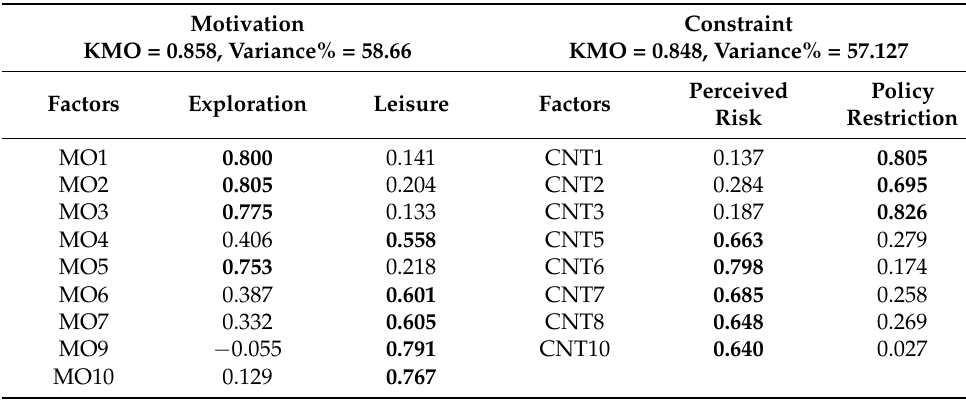
Table 3. The results of exploratory factor analysis (EFA). Motivation KMO = 0.858, Variance% = 58.66